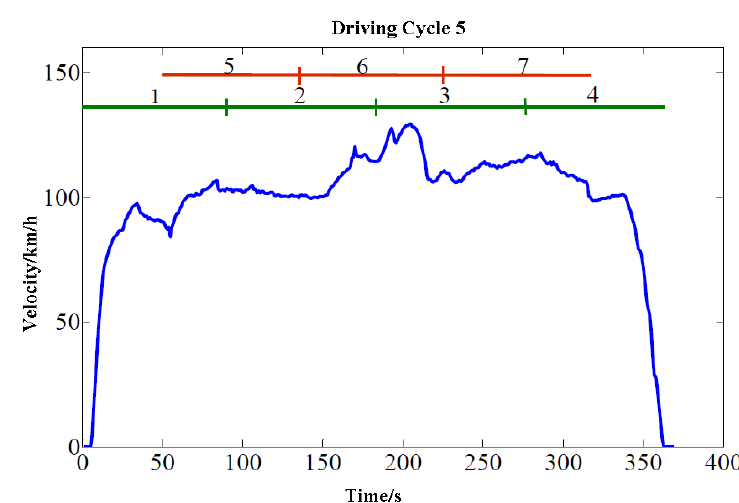
Figure 5. Micro-trip partition of driving cycle 5.